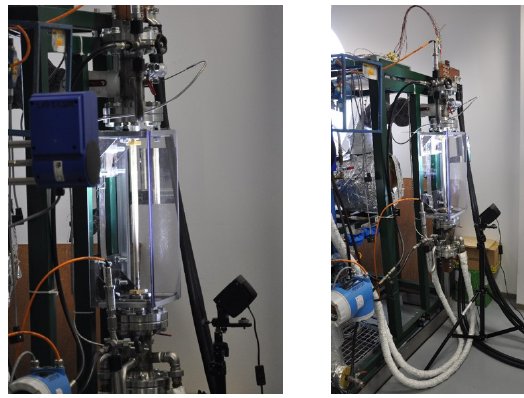
Figure 1. Setup for slow motion recording